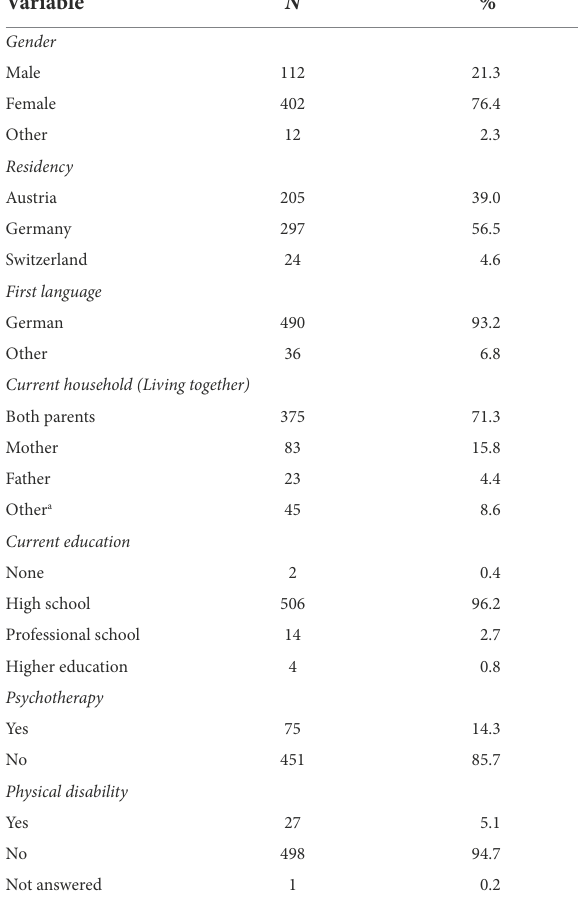
TABLE 1 Socio-demographic characteristics of the final